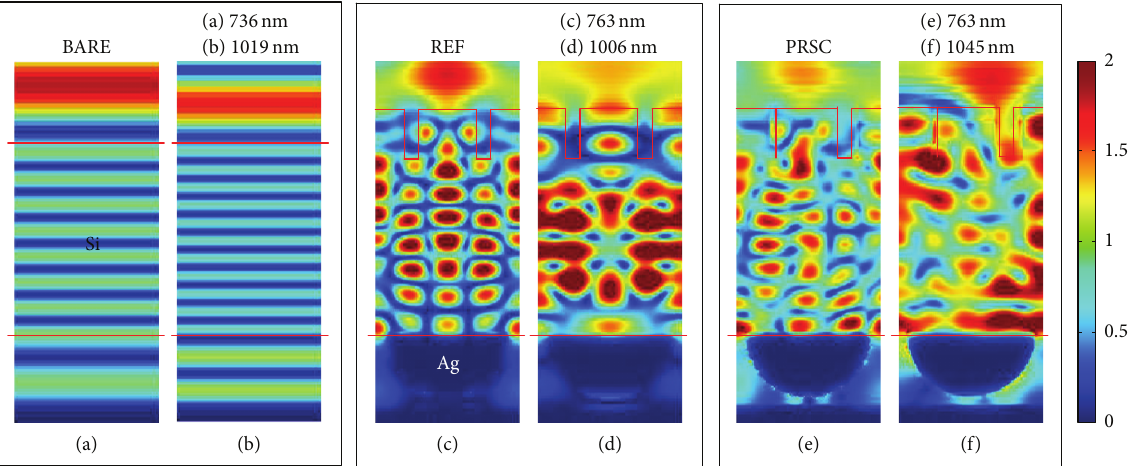
Figure 5: The electromagnetic field maps of the BARE cell (a, b), the REF cell (c, d), and the PRSC (e, f), respectively. The wavelength selected for the BARE cell is of (a) 736 nm and (b) 1019 nm and for the REF cell is of (c) 763 nm and (d) 1006 nm, while for the PRSC it is of (e) 763 nm and (f)